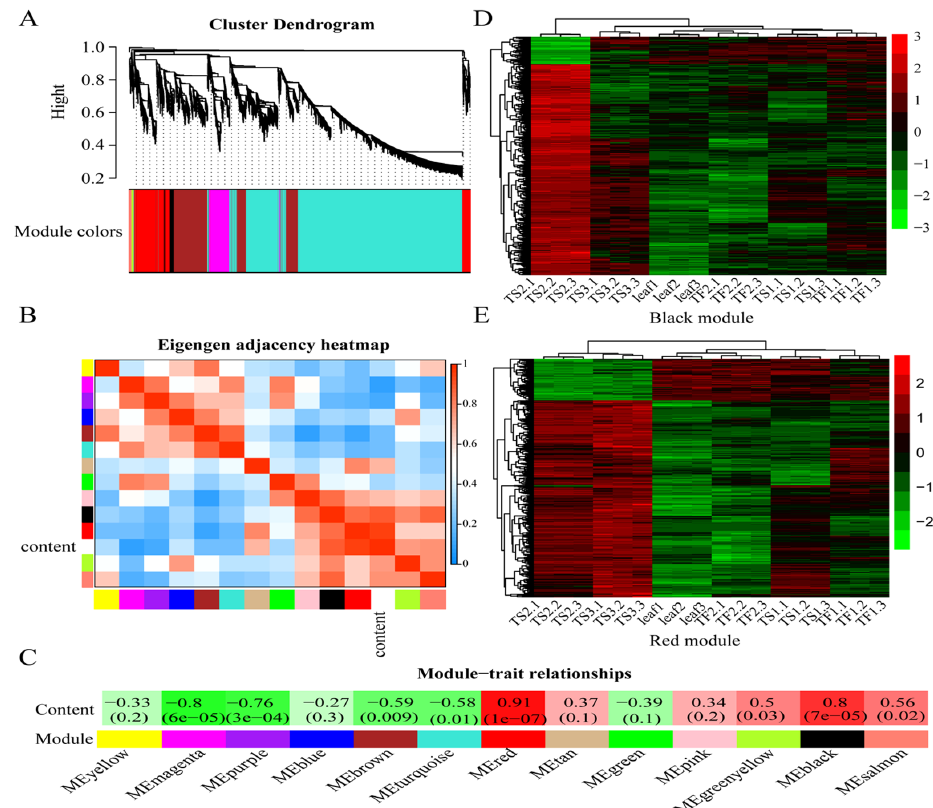
Figure 3. Weighted gene coexpression network analysis (WGCNA) and modules related to saponin biosynthesis. ( A ) Cluster dendrogram showing 13 coexpressed gene modules identified via WGCNA. Each module is labeled with a different color. ( B ) Eigengene adjacency heatmap showing the relationship between the modules with each other and saponin content. ( C ) Pearson correlation coefficient (R) and the p value for saponin content and each module. ( D ) Cluster heat map of the differentially expressed genes (DEGs) from the MEblack module. ( E ) Cluster heat map of DEGs from the MEred module. The color in the heat map represents the corresponding FPKM value of genes.